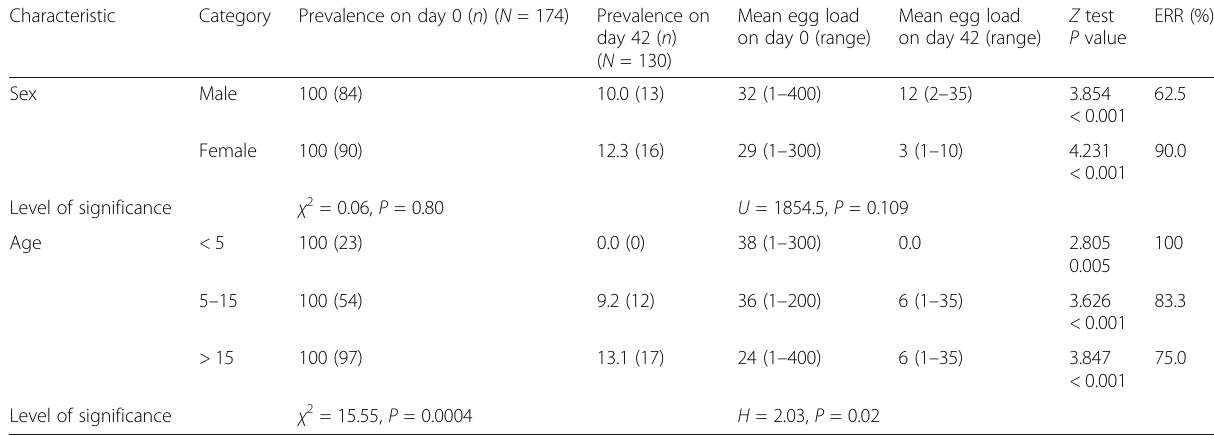
Table 2 Efficacy of praziquantel against S. haematobium with respect to gender and age in the Ikata-Likoko area of southwest Cameroon Characteristic